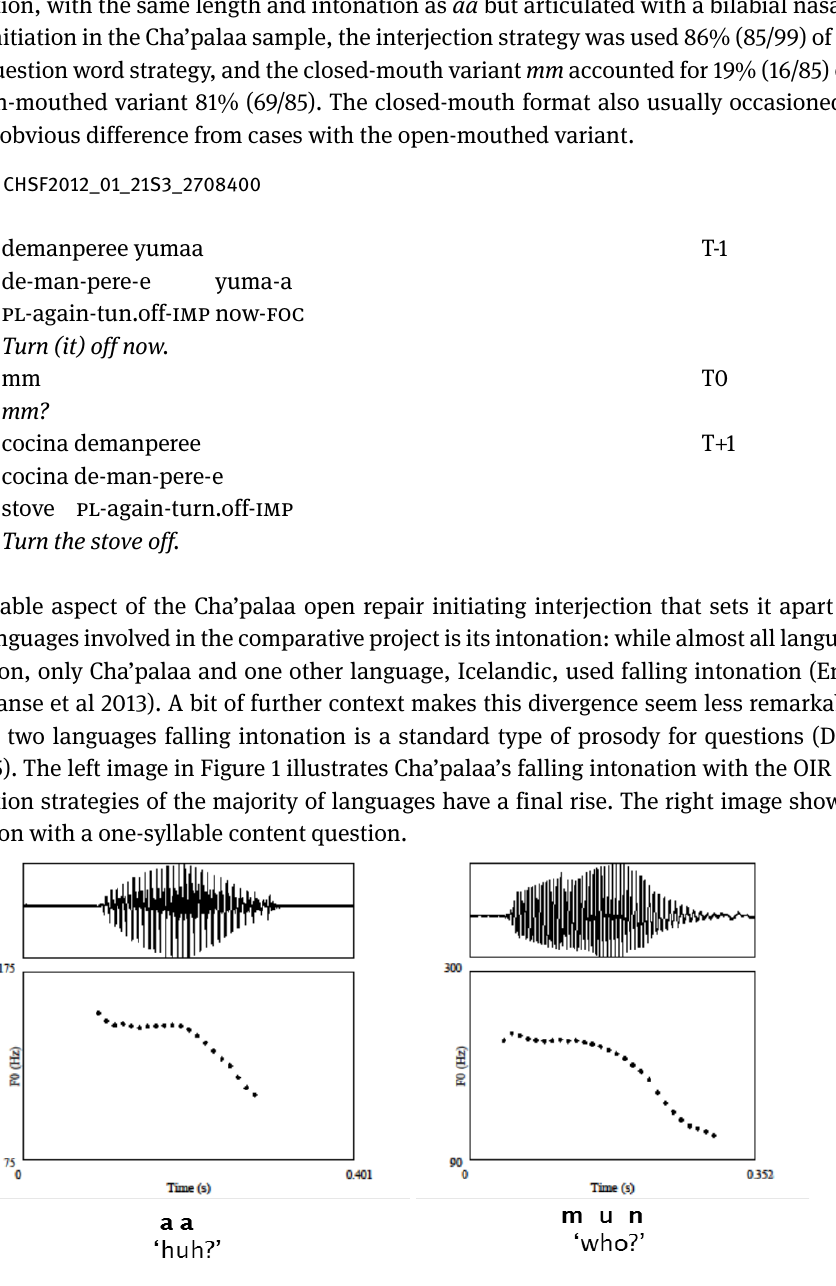
Figure 1. Cha’palaa open repair initiator interjection compared to a one-syllable content question mun ,